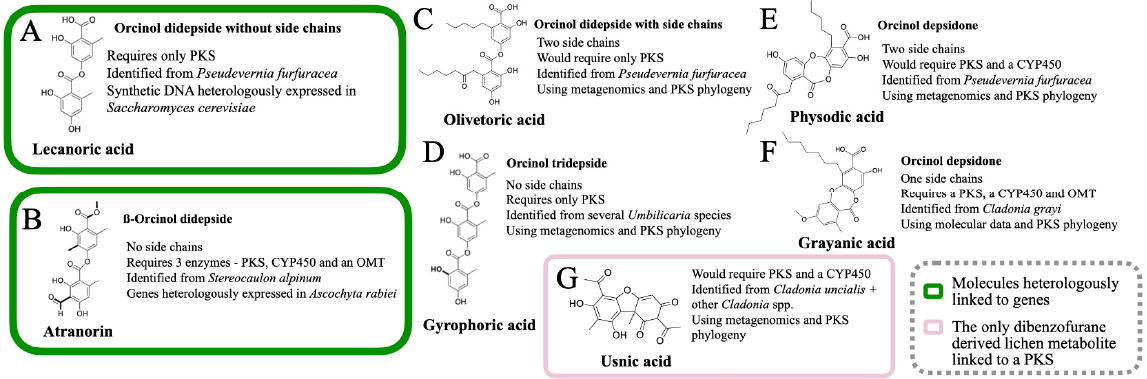
Figure 3. The lichen compounds that are linked to a PKS. The compounds highlighted in green are the ones in which the link between the molecule and the PKS was also verified by heterologous expression. A lecanoric acid, B) atranorin, C) olivetoric acid D) gyrophoric acid, E) physodic acid, F) grayanic acid and G) usnic acid